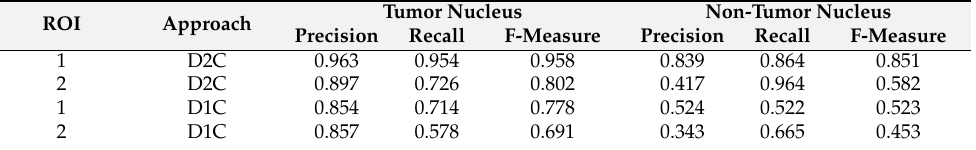
Table 6. Metrics on the external validation ROIs.